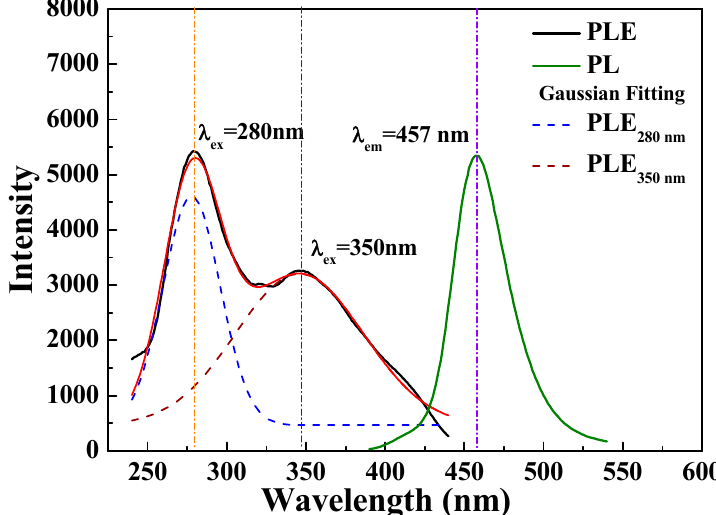
Figure 5. PLE and PL spectra of the [Sr 0.99 Eu 0.01 ] 3 MgSi 2 O 8 phosphors sintered for 5 h.